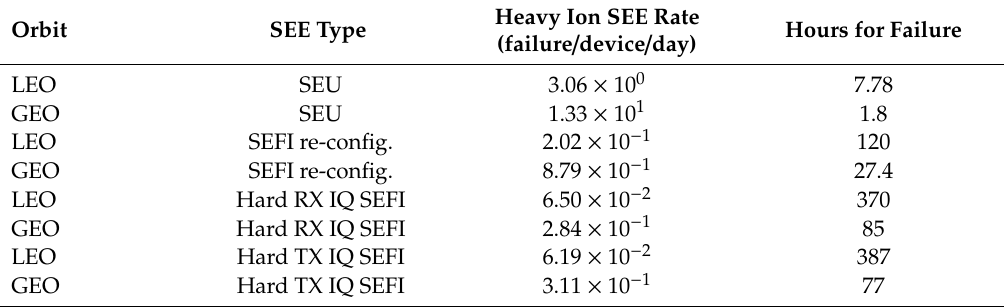
Table 5. Error rates for two references missions and the observed SEEs (launch date: 1st December 2019) for worst case conditions (one day solar